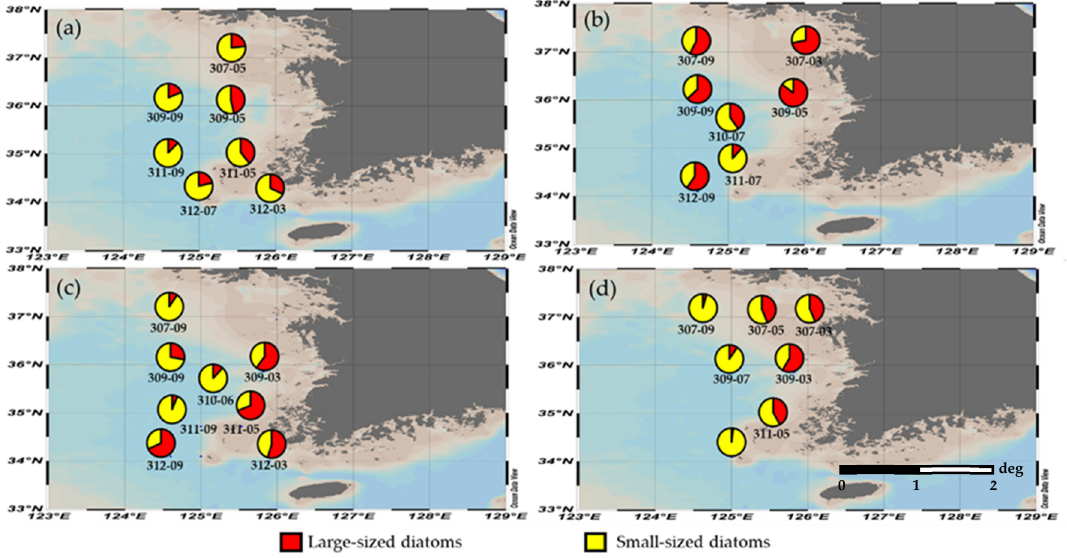
Figure 7. Relative contributions of size-fractionated diatoms during the study period in 2019: ( a ) winter; ( b ) spring; ( c ) summer; and ( d ) autumn.